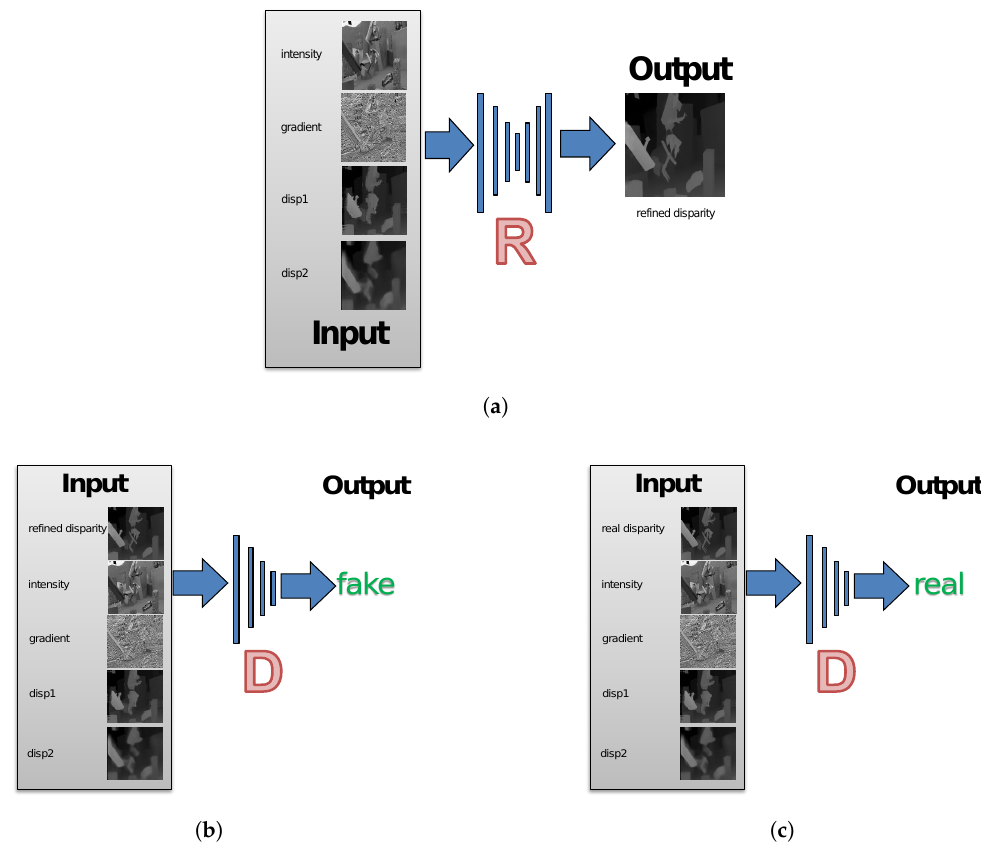
Figure 1. Overview of Sdf-MAN. We train a refiner network R to map raw disparity maps ( disp1 , disp2 ) from two input algorithms to the ground truth based on associated image information (gradient, intensity). The refiner R tries to predict a refined disparity map close to the ground truth. The discriminator D tries to discriminate whether its input is fake (refined disparity from R ) or real (real disparity from the ground truth). The refiner and discriminator can see both the supplementary information and initial disparity inputs simultaneously. We can fuse any number of disparity inputs or different information cues by concatenating them together directly as inputs. The two networks are updated alternately. ( a ) Refiner: a network to refine initial disparity maps; ( b ) Negative examples: a discriminator network with refined disparity inputs; ( c ) Positive examples: a discriminator network with real disparity